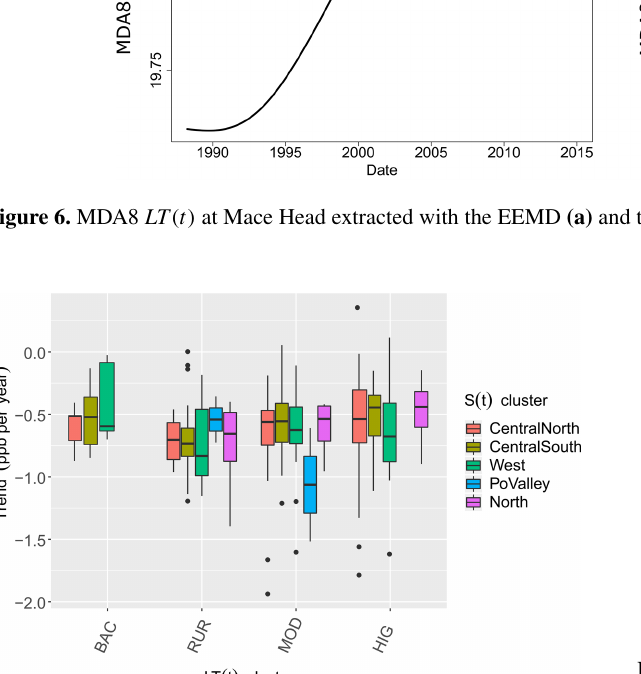
Figure 8. Annual cycle of daily mean O 3 S(t) for the daily mean S(t)